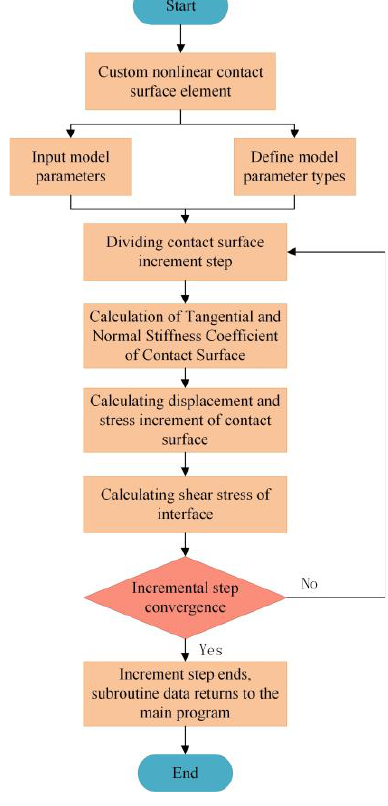
Figure 23. Operation flow chart.